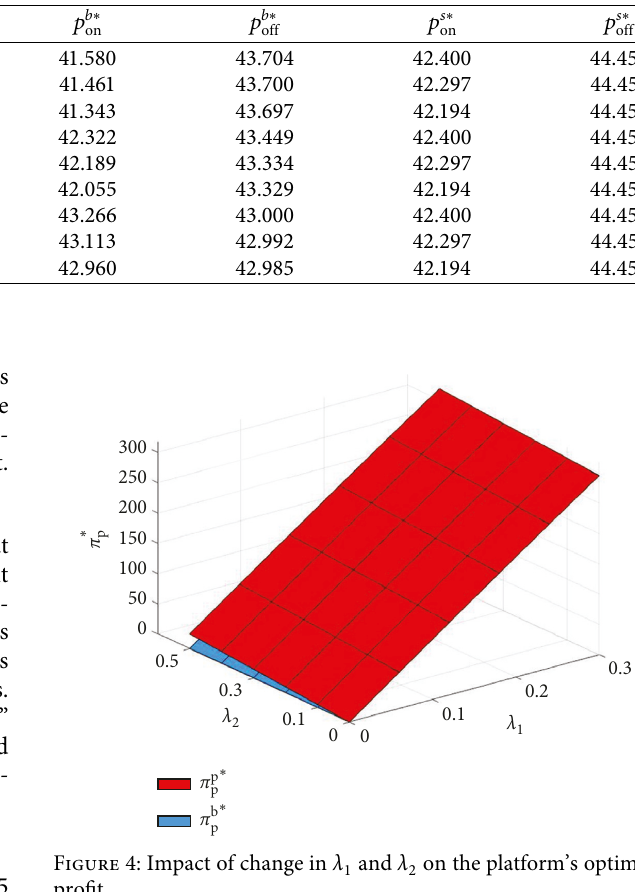
1 and λ 2 on the platform’s optimal